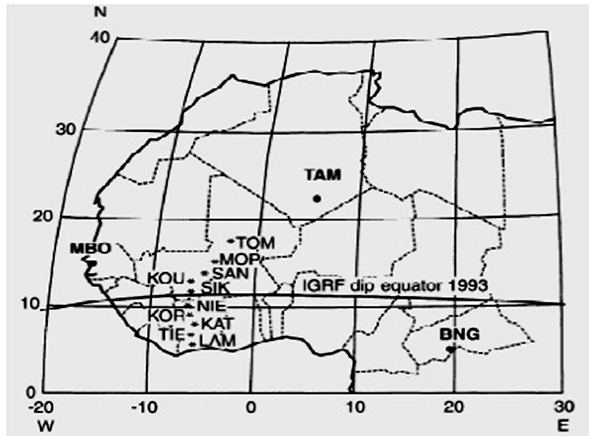
Figure 1. The West African network of 10 stations for the geomag- netic and telluric field measurements during the International Equa- torial Electrojet Year